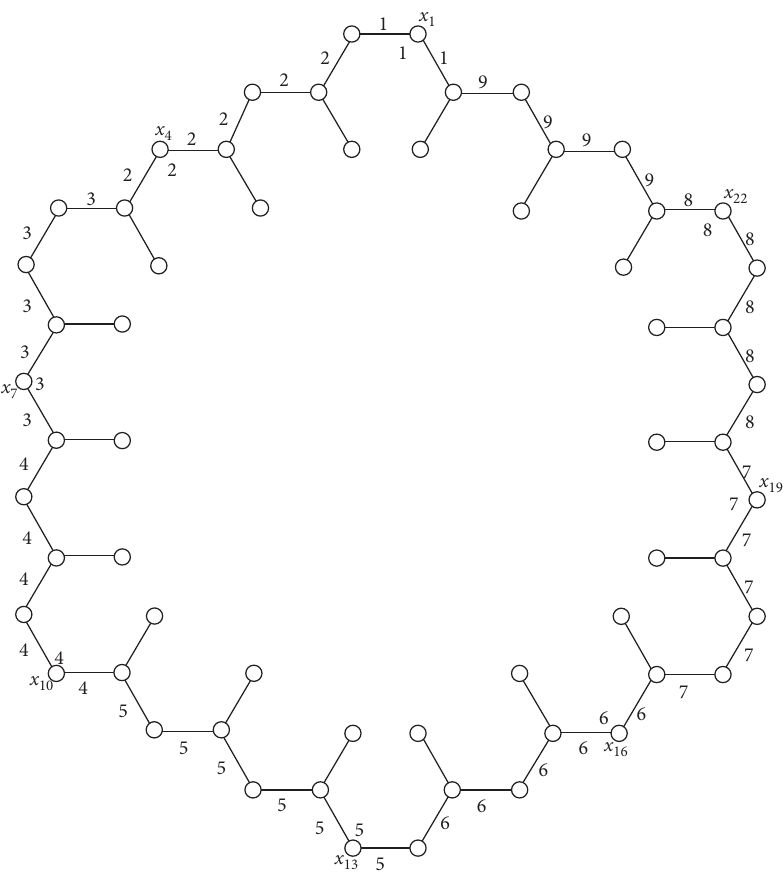
Figure 7: The labels of some vertices and edges of L